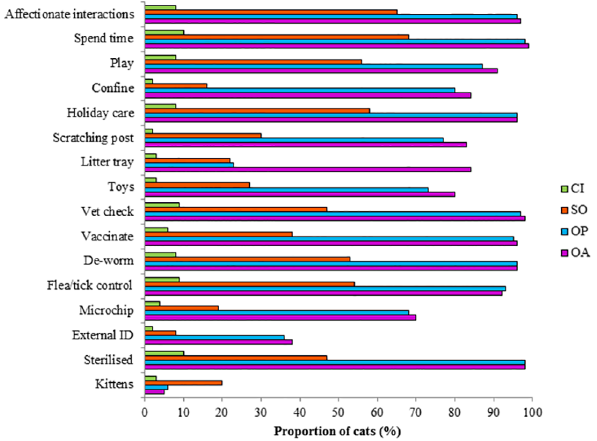
Fig 1. Interactions with and caretaking of study cats in four human-cat relationship categories. Proportions of 1305 study cats in various human-cat relationship categories that were reported to have had kittens, been sterilized, been microchipped, and had received various interactions and caretaking behaviours. CI = casual interaction, SO = semi-ownership, OP = ownership of a passively acquired cat and OA = ownership of an actively acquired cat. Flea/tick control, de-worm, vaccinate and vet check proportion includes those cats that received these caretaking behaviours occasionally or regularly. Toys, litter tray and scratching post proportion includes those cats for which these were provided often or always. Holiday care proportion includes those cats for which holiday care was organized sometimes or always. Confine, play, spend time and affectionate interactions (holding, stroking, and cuddling the cat) proportion includes those cats that received these interactions or caretaking behaviours sometimes or daily. ID = identification.